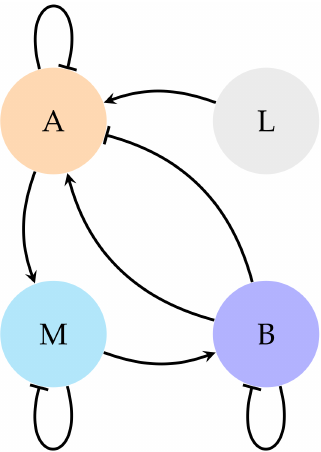
Figure 6. Gene circuit of the lac operon.